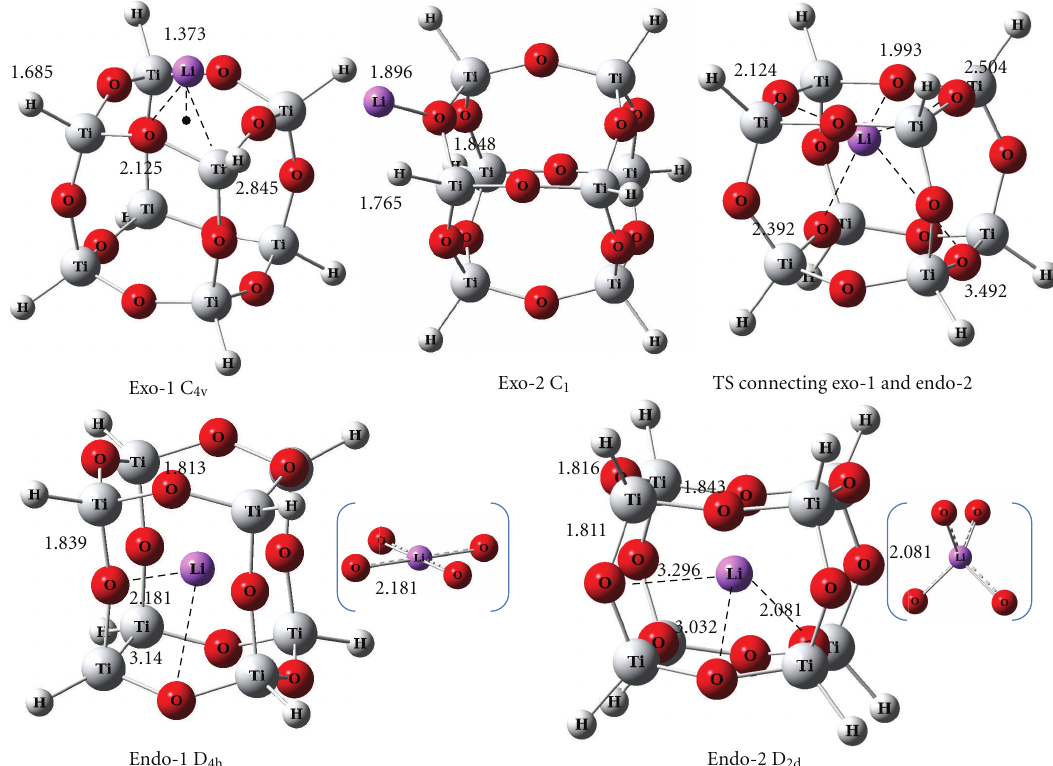
Figure 2: The B3LYP/6-311+G(d) optimized geometries of the exohedral and endohedral complexes and the transition state connecting “Exo-1” and “Endo-2” of Li + and Ti-T 8 in angstroms.